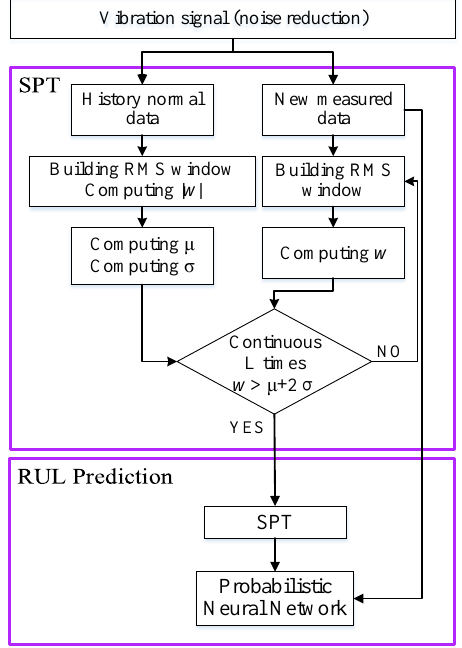
Figure 4. Flowchart of remaining useful life (RUL) prediction.